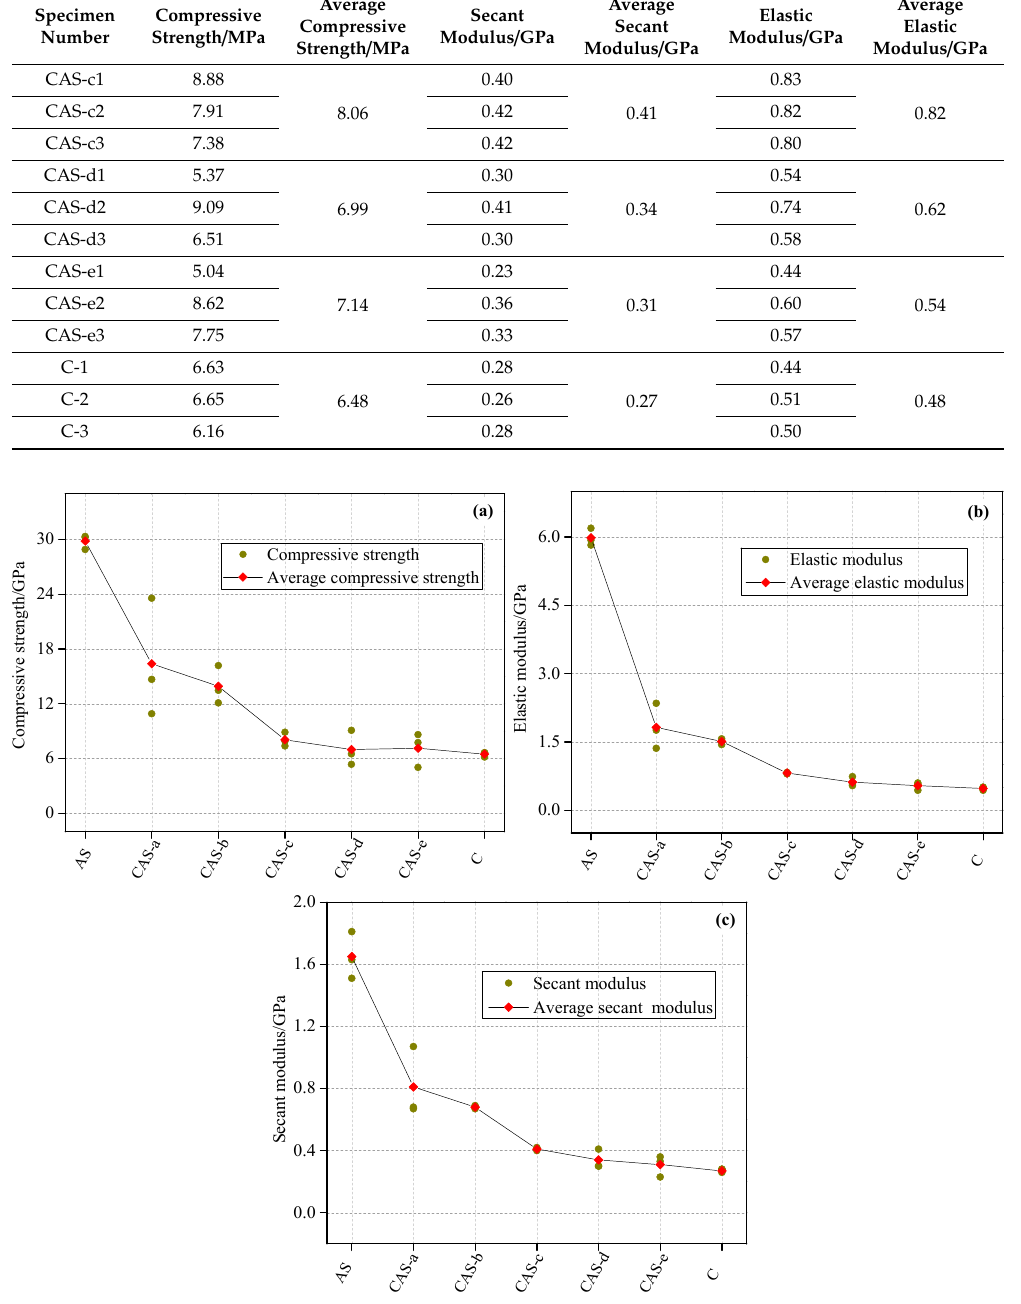
Figure 6. Mechanical properties of combinations with different coal–rock height ratios: ( a ) compressive strength and average compressive strength; ( b ) elastic modulus and average elastic modulus; ( c ) secant modulus and average secant modulus.